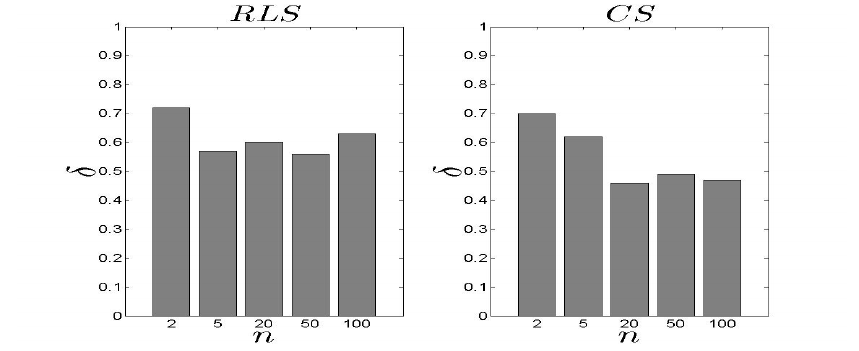
Figure 11. RLS and CS results for the δ metric ( |F| = 10).